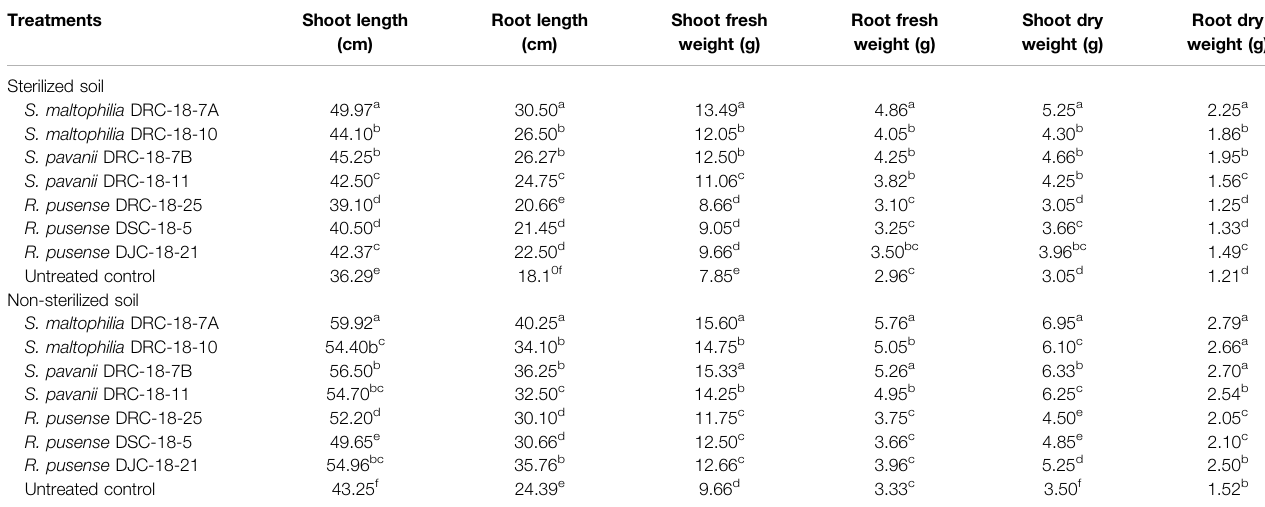
TABLE 5 | Effect of seed inoculation on plant growth parameters of pigeonpea grown in pots after 60 days of sowing.